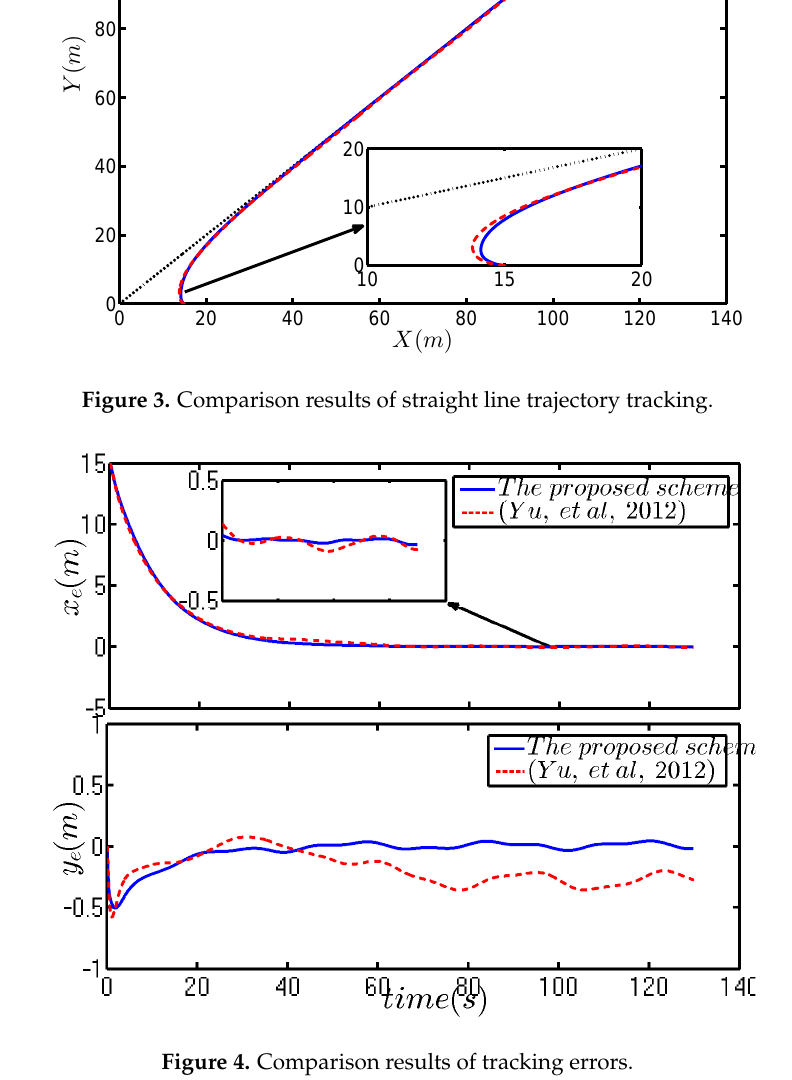
Figure 4. Comparison results of tracking